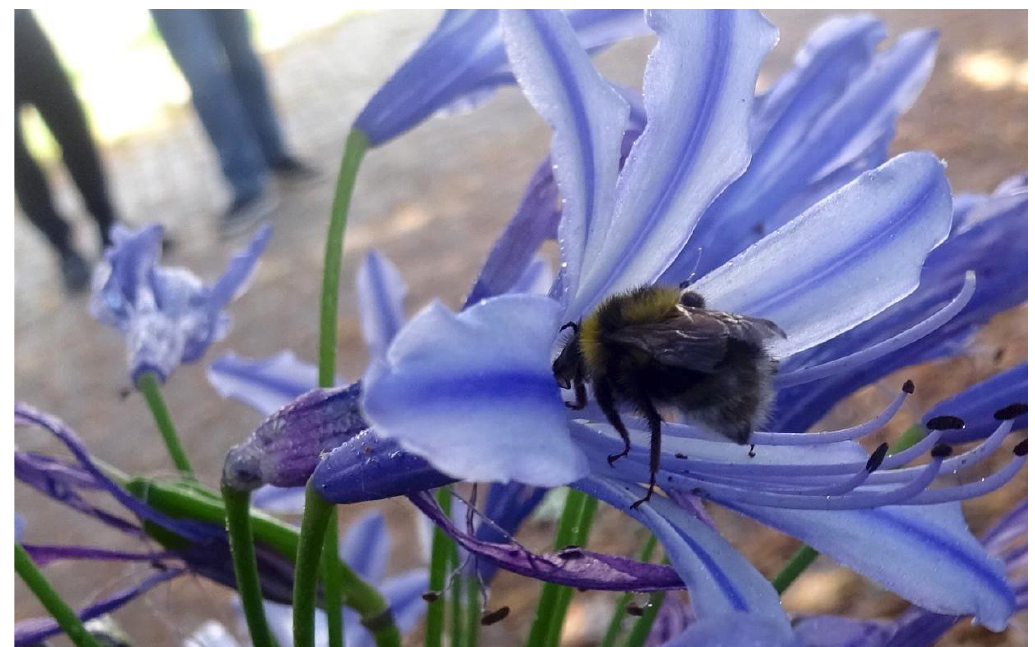
Figure 2. Nature at the EC. Source: Photo taken by an institutionalised youth. that used to go unnoticed. The photographs revealed a high standard of technical and compositional quality.